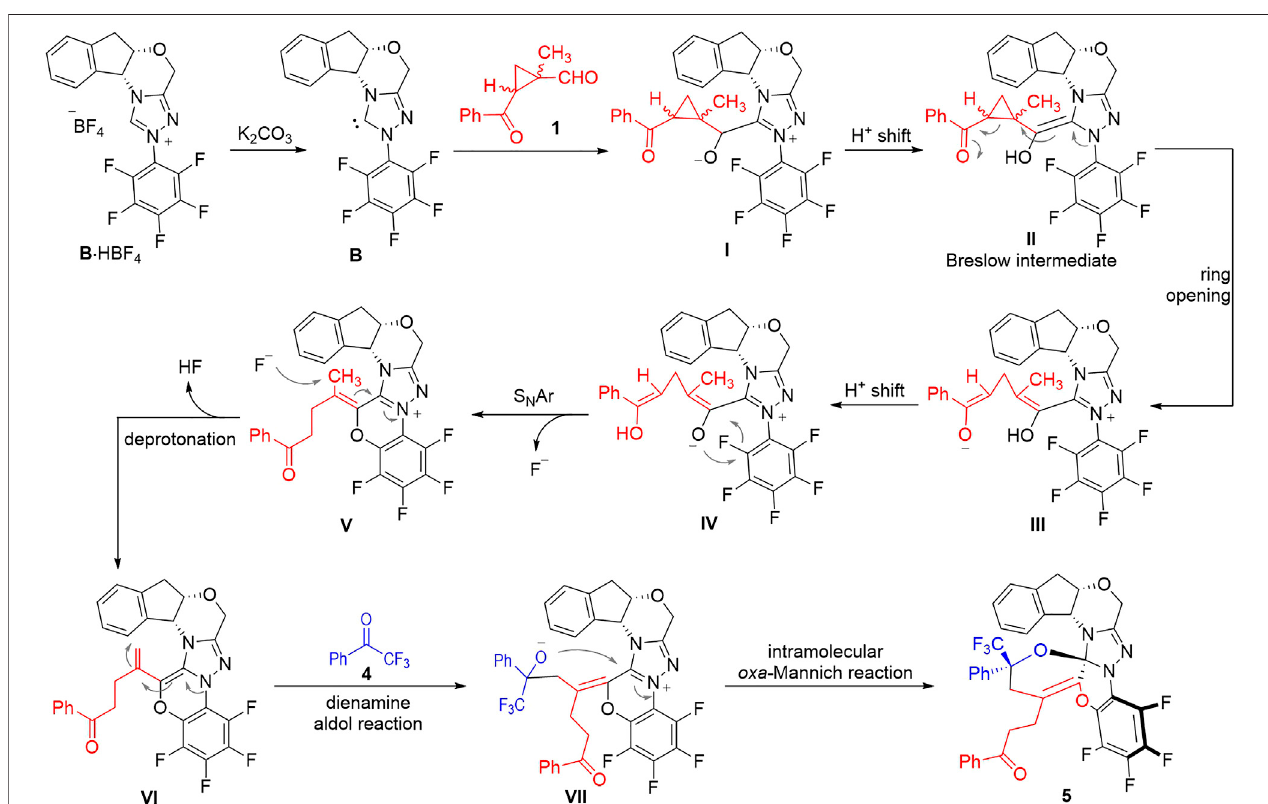
FIGURE 3 | Proposed reaction mechanism for the formation of the product 5